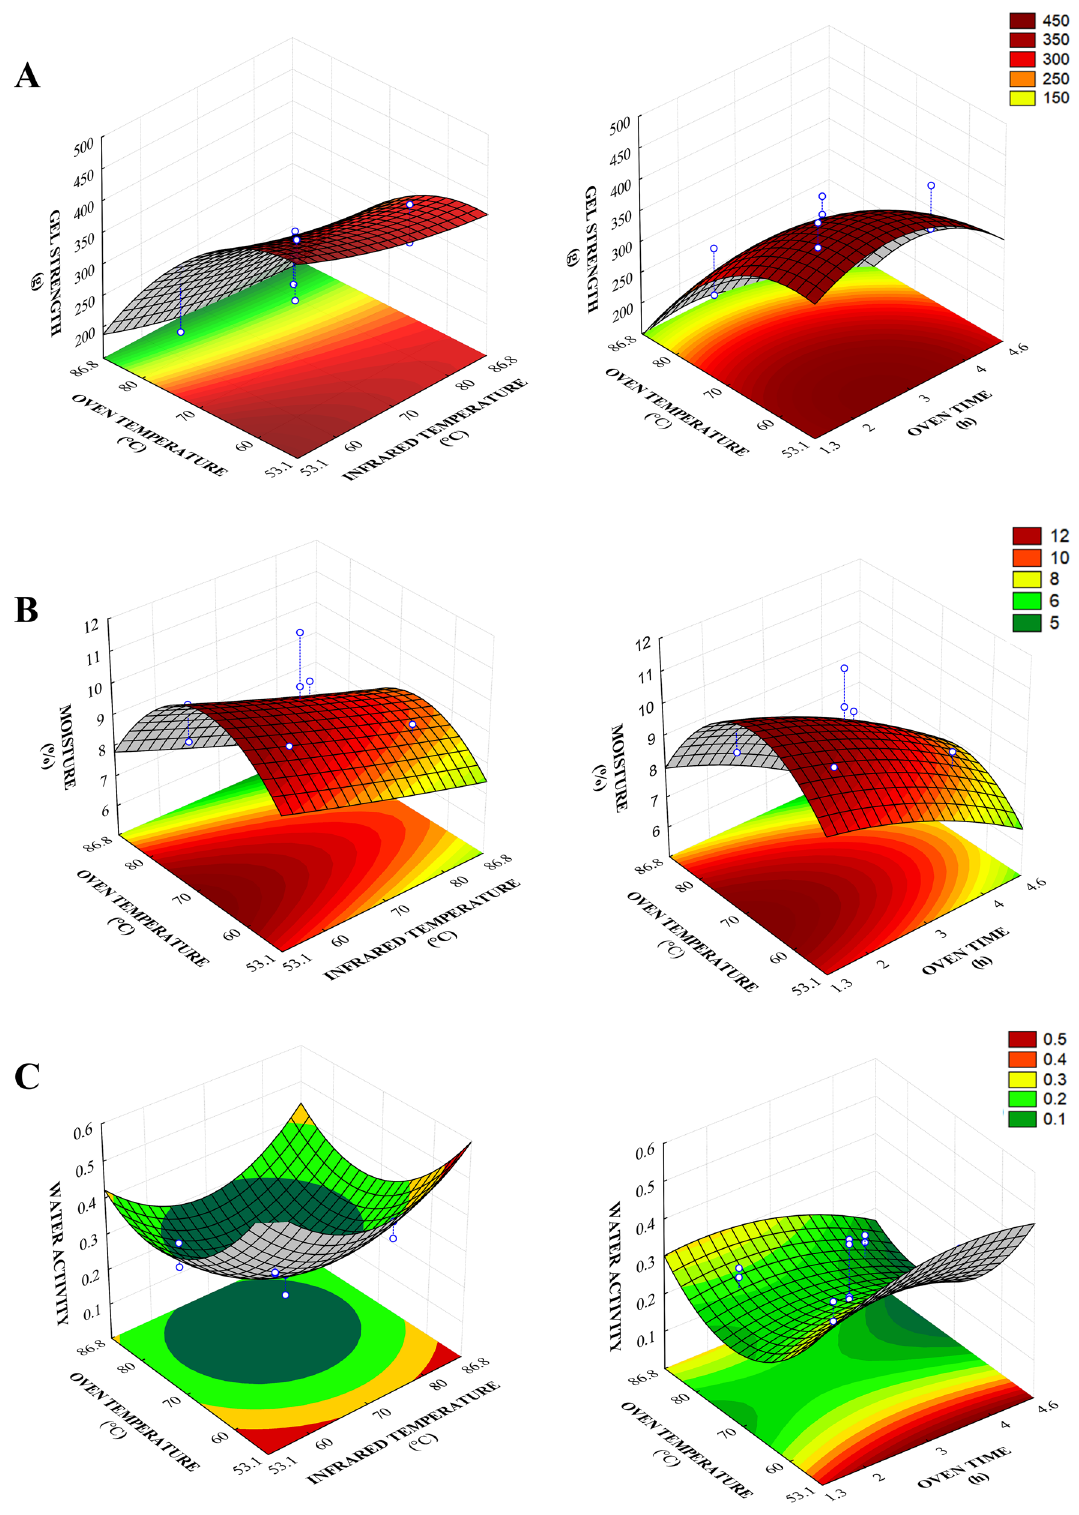
Figure 3. Response surface for gel strength ( A ), moisture ( B ), and water activity ( C ) relating oven time and temperature and infrared temperature of the combined drying of gelatin